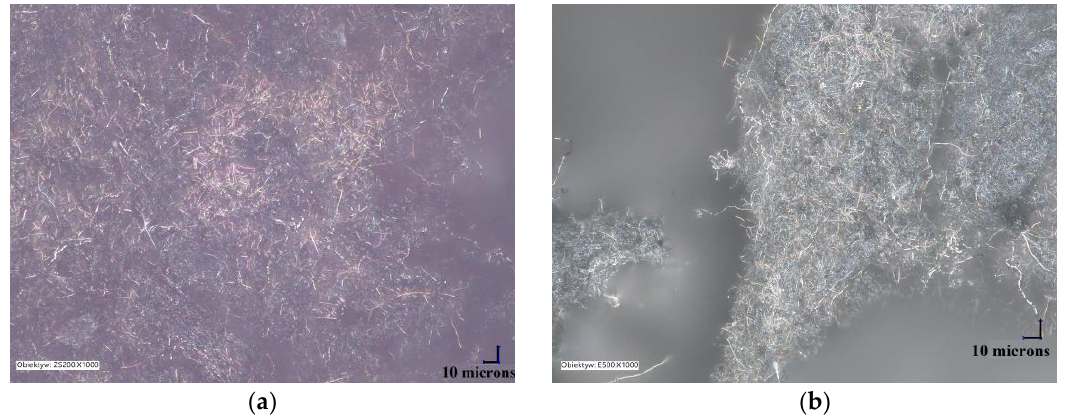
Figure 3. Optical microscopy images: ( a ) raw carbon nanofibers, and ( b ) APTS-modified carbon nanofibers.